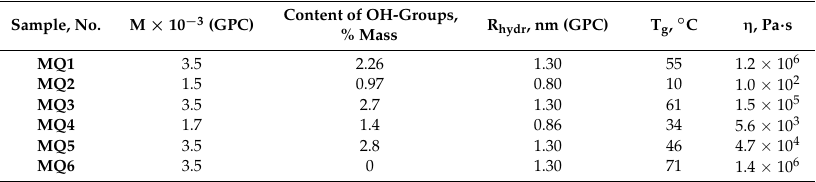
Table 1. Main characteristics of MQ